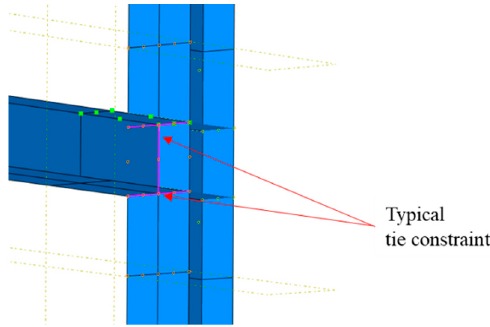
Figure 6. Typical tie constraint at beam-column connection.